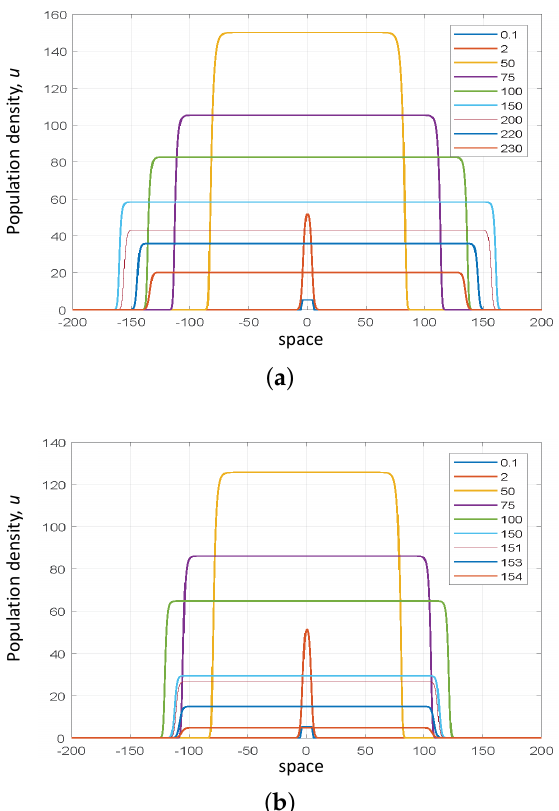
Figure 5. Solution of Model (8) shown at different moments of time (as is explained in the figure legend) obtained for m 1 = 3 and different values of the final withdrawal rate: ( a ) for m 0 = 5.4 and ( b ) for m 0 = 5.8. Other parameters are (cid:101) = 3, (cid:101) 1 = 0, a = 150, h = 35, b = 0.01, and D =